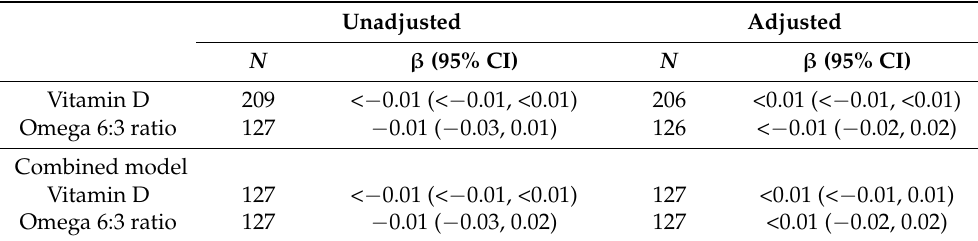
pain sites. Combined model: regression models included both vitamin D and omega 6:3 ratio as predictors along with other